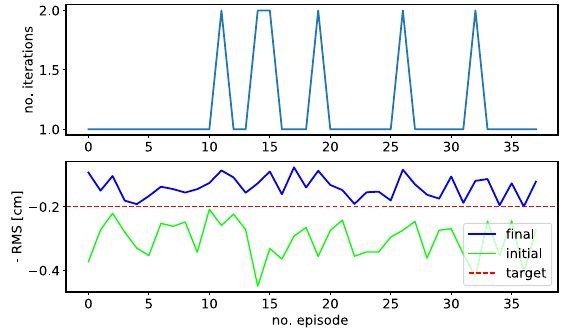
FIG. 10. Validation on accelerator on September 22, 2020, of agent that was trained more than three months earlier (June 10, 2020). The agent corrects the trajectory to better than 2 mm RMS within 1-2 iterations. No retraining was required.